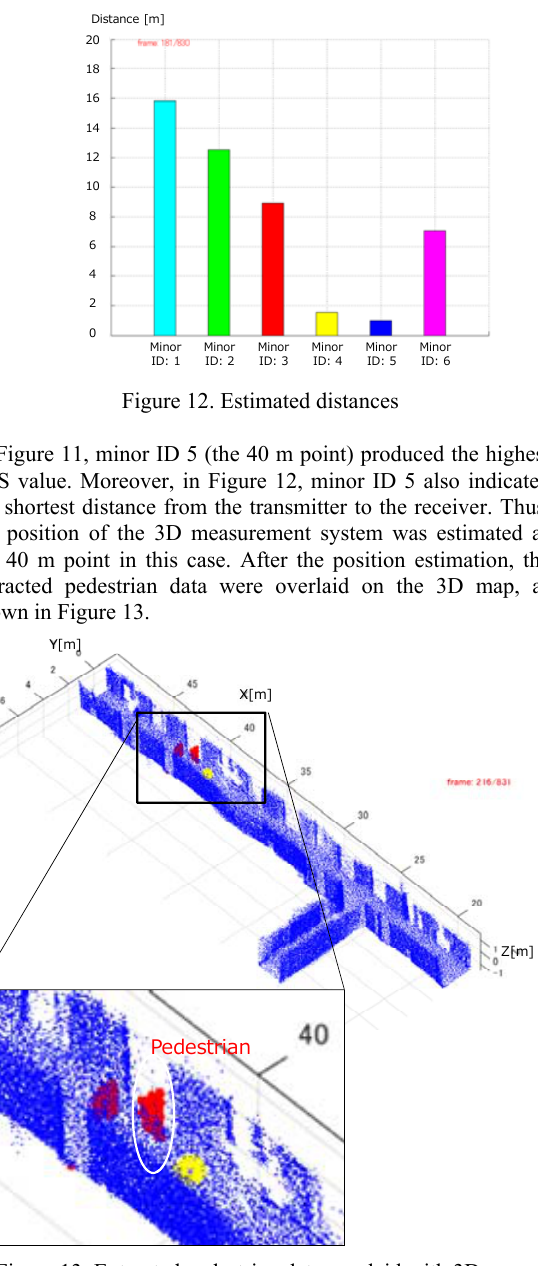
Figure 11. RSS values